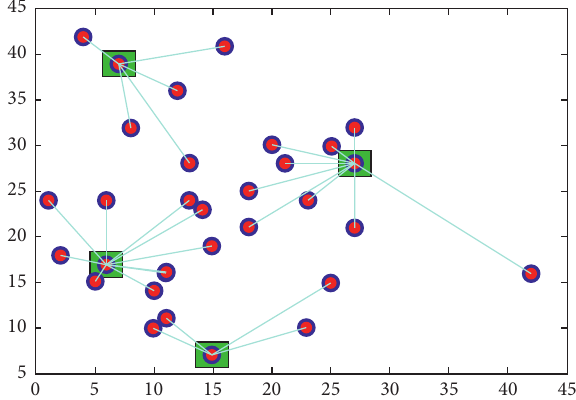
Figure 8: Customer ownership in a dynamic environment.